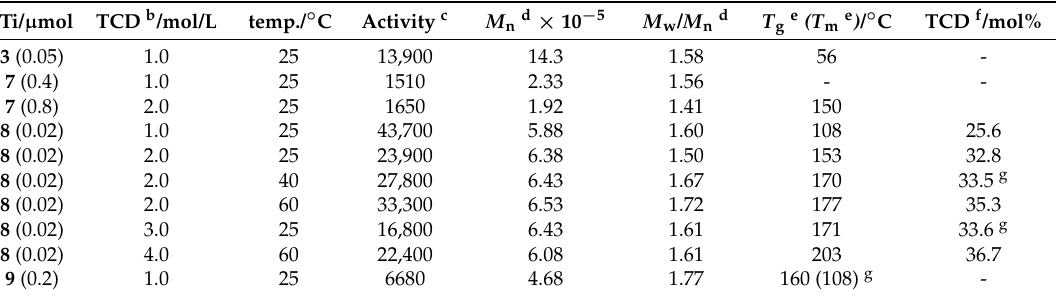
a Polymerization conditions: toluene and TCD total 30 mL, ethylene 6 atm, 10 min, d ‐ MAO (prepared by removing toluene and AlMe 3 from the ordinary MAO) 3.0 mmol; b initial monomer concentration;